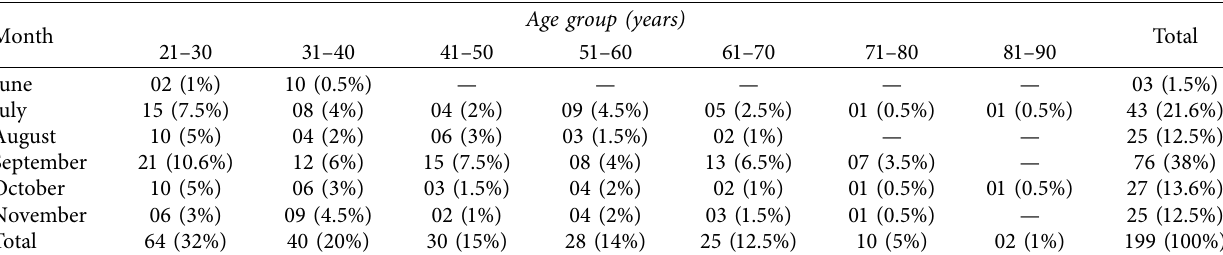
Figure 1: Tree channel surgical protocol. Table 1: Age-wise distribution of the study population who were COVID-19 positive.